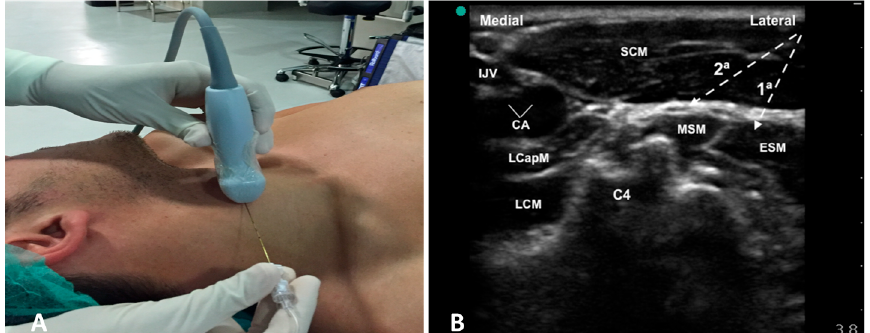
Figure 1. Ultrasound-guided cervical plexus block. ( A ) Position of the ultrasound probe and puncture site at the carotid bifurcation. ( B ) Ultrasound image of the deep (1st) and intermediate (2nd) cervical plexus block. SCM: sternocleidomastoid muscle; LCM: longus colli muscle; LCapM: longus capitis muscle; MSM: middle scalene muscle; ESM: elevator scapulae muscle; IJV: internal jugular vein; CA: carotid artery bifurcation; C4: C4 vertebra transverse